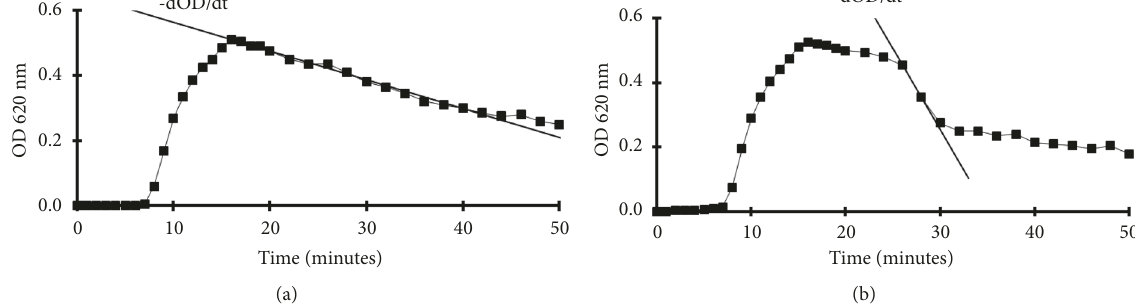
Figure 1: Crystallization curves in urine obtained by Ox titration. (a) Urine with inhibition of AGN demonstrated by slow decrease of optical density (-dOD/d). (b) Urine with massive AGN indicated by a phase of rapid -dOD/dt.